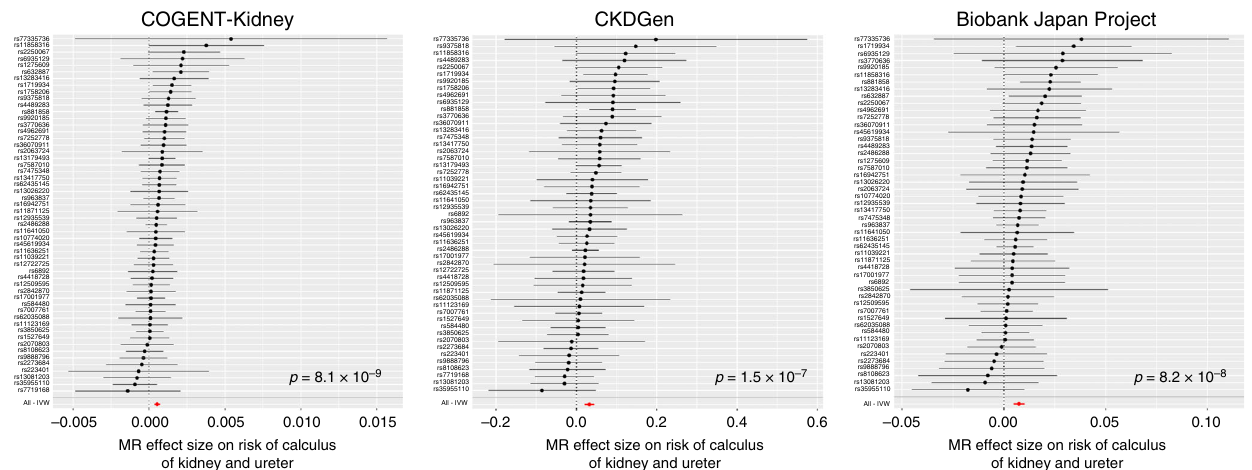
Fig. 3 Two-sample MR of eGFR on calculus of kidney and ureter. Results are presented separately for each component of the trans-ethnic meta-analysis. Each point corresponds to a lead SNV (instrumental variable) across 94 kidney function loci, plotted according to the MR effect size of eGFR on calculus of kidney and ureter (Wald ratio). Bars correspond to the standard errors of the effect sizes. The red point and bar in each plot represents the MR effect size of eGFR on calculus of kidney and ureter across all SNVs under inverse variance weighted regression. The p -values are obtained under inverse variance weighted regression. Results for other methods are presented in Supplementary Table 8